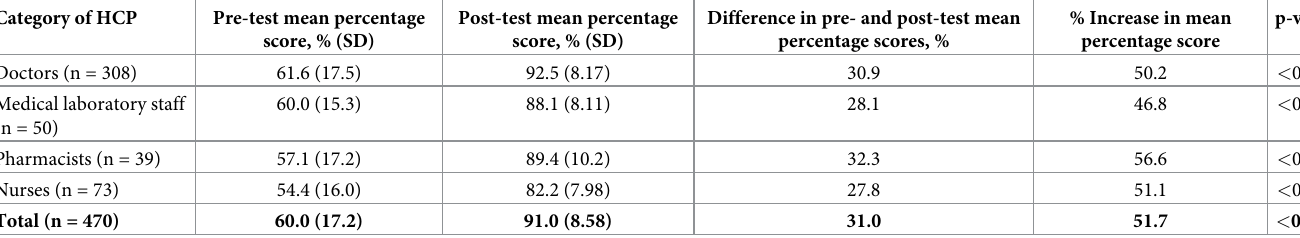
Table 3. Mean percentage scores of participant by work